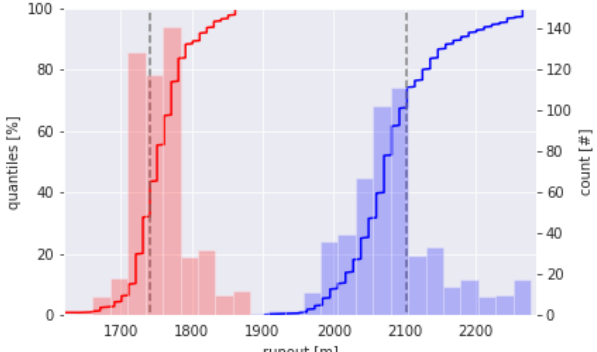
Figure 3. Runout statistics of the forward and predictive simulations with the Monte Carlo sample ( θ pred , N = 500) for the Kerngraben (red) and Wolfsgruben (blue) avalanche with the observed runouts post (dashed black line). Solid lines (red, blue) depict the quantiles of the resulting runout distribution and transparent bars the corresponding histograms. The observed runout for the Kerngraben avalanche is r = 1741m, with the 95–5% quantiles ranging from 1701 to 1831m and r = 2103 m for the Wolfsgruben avalanche with a range of 1985m to 2233m for the 95–5% quantiles.